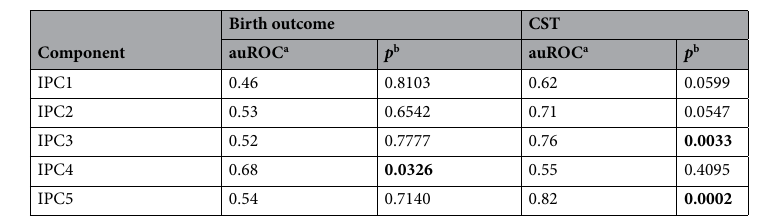
Table 2. Prediction of birth outcome and Community State Type (CST) using the 5 independent components (IPC1-5) and the difference of IPC1-5 by birth outcome and by CST. a auROC: Area under the receiver operating characteristics. b t-test P values for components significantly differing by birth outcome and by CST ( p < 0.05) are